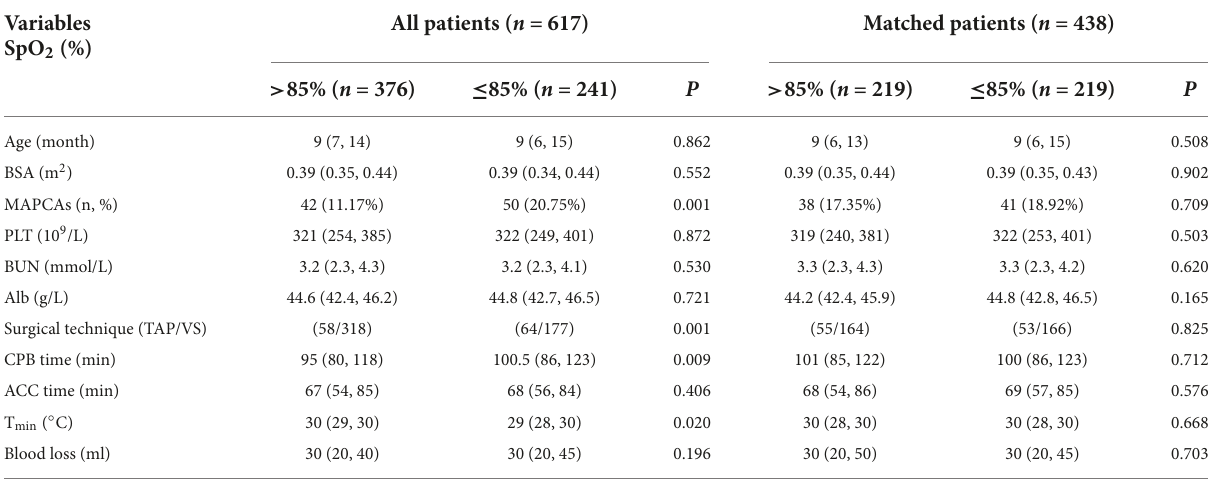
TABLE 3 The demographic and perioperative data before and after